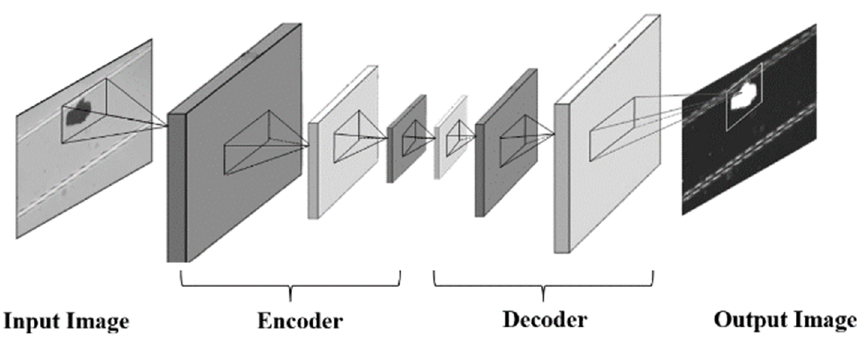
Figure 12. Schematic diagram of segmentation network model